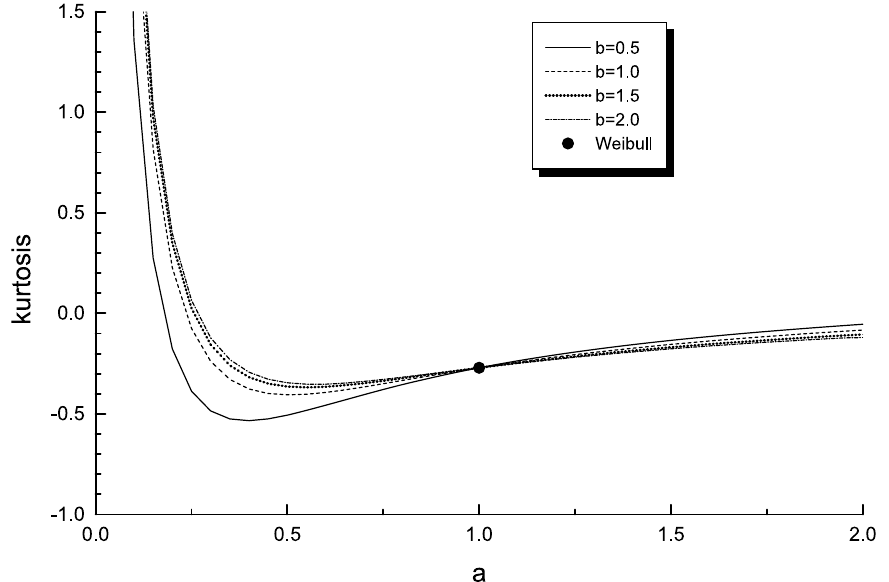
Fig. 4 – Kurtosis of the BW distribution as a function of parameter a for selected values of parameter b